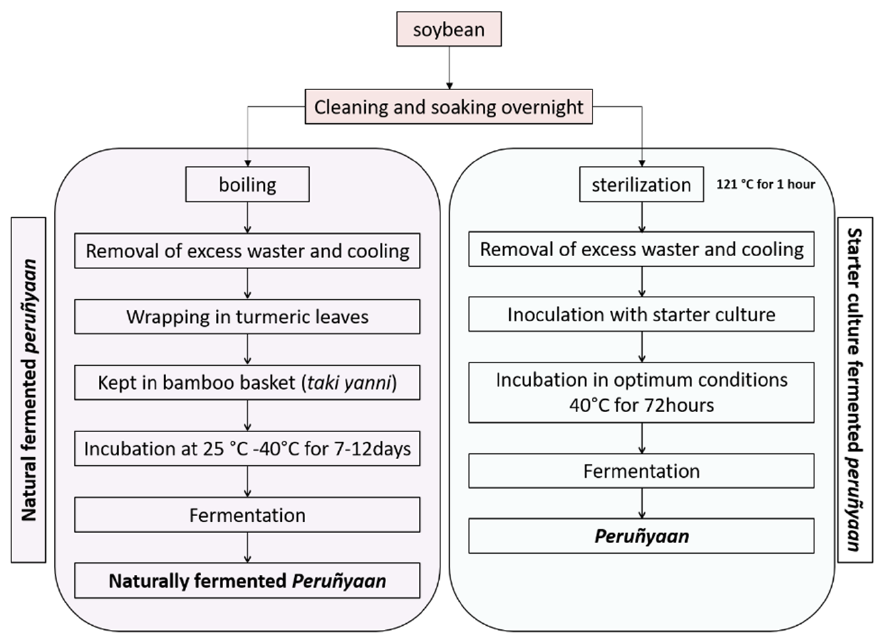
Figure 3. Comparative flowchart for the naturally fermented soybean food peruñyaan and starter culture ( B. safensis subsp. safensis PY1-19) fermented- peruñyaan .